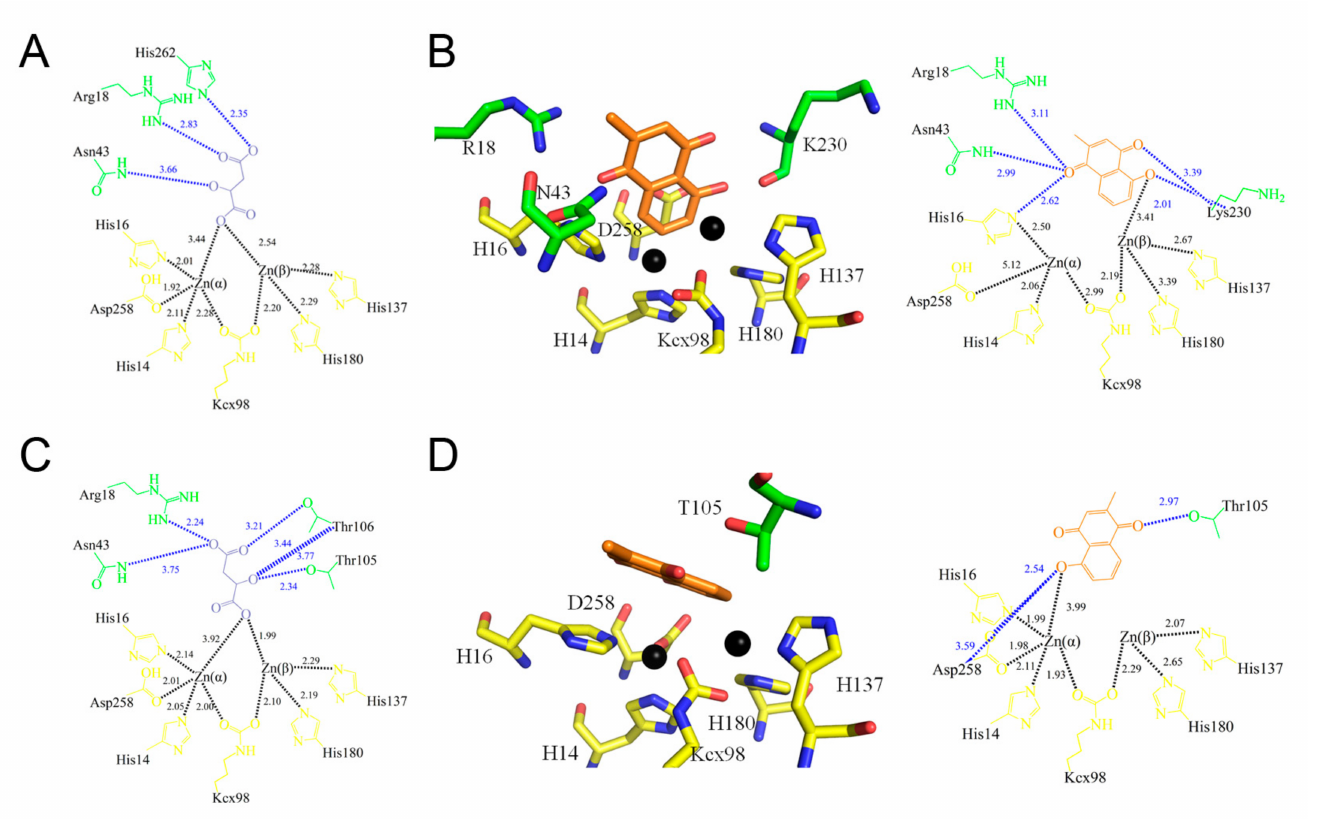
Figure 5. PLU and malate binding modes. ( A ) The active site of subunit A with malate (in dark blue). Arg18, Asn43, and His262 were involved in malate binding. Residues required for metal binding are colored in yellow. ( B ) The active site of subunit B with PLU (in orange). His16, Arg18, Asn43, and Lys230 were involved in PLU binding. Zn atoms are shown in black spheres. ( C ) The active site of subunit C with malate. Arg18, Asn43, Thr105, and Thr106 were involved in malate binding. ( D ) The active site of subunit D with PLU. Thr105 and Asp258 were involved in PLU binding. Note that the individual distances between the metal-binding residue Asp258 and Zn α in subunits B and D are